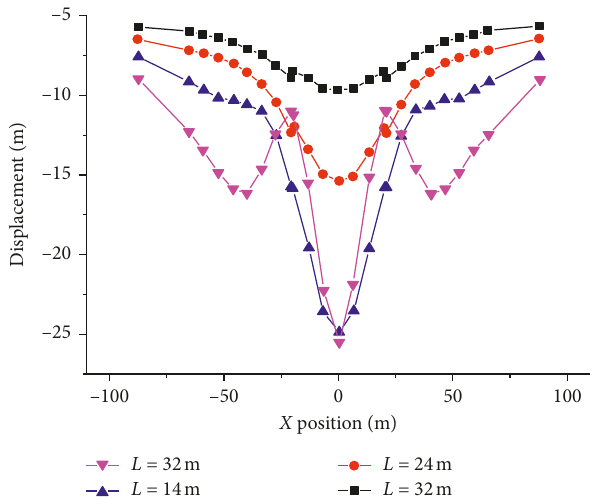
Figure 17: Soil settlement beside the pit. Figure 18: Comparison between the simulative value and measure value of pipeline vertical